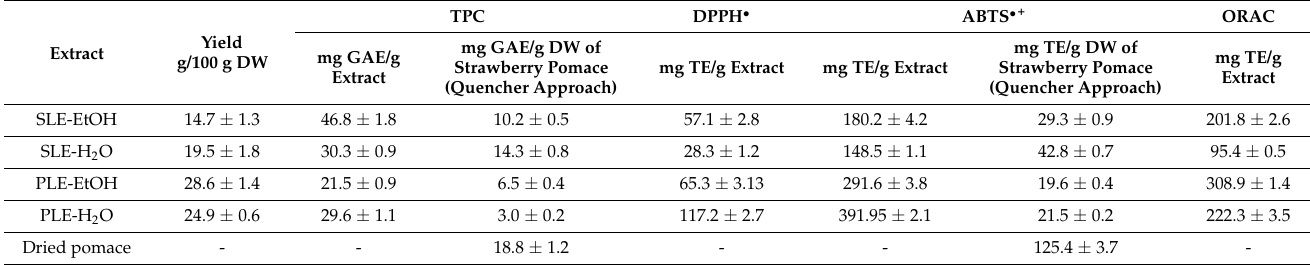
Table 3. Total phenolic content and antioxidant capacity of extracts and solid